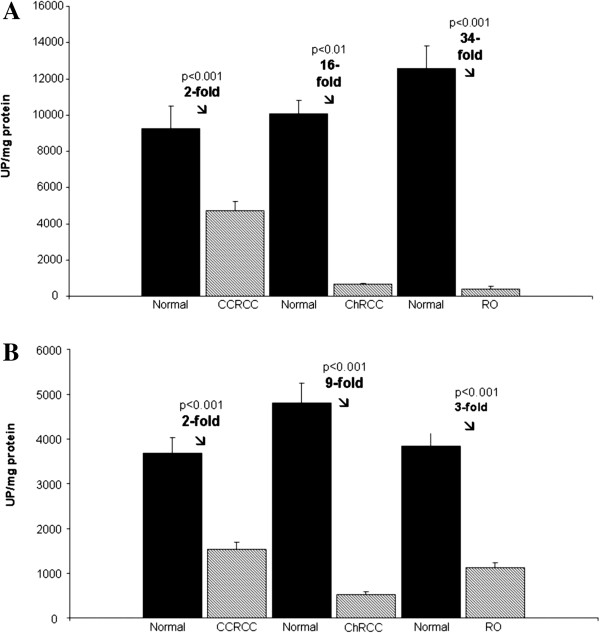
Glutamyl-aminopeptidase activity profile in the membrane-bound (A) and soluble fraction (B) of CCRCC, ChRCC and RO. The columns compare tumour with non-tumour surrounding tissue (normal). Values represent mean ± SE of enzyme activities recorded as units of enzyme per milligram of protein (U/mg prot). Mann–Whitney test: (***) P < 0.001; (**) P < 0.01.